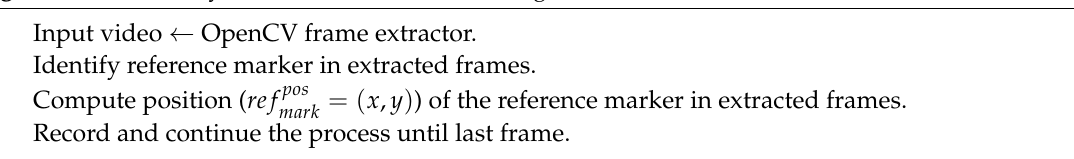
Algorithm 2 Frame-by-Frame Marker Detection Algorithm